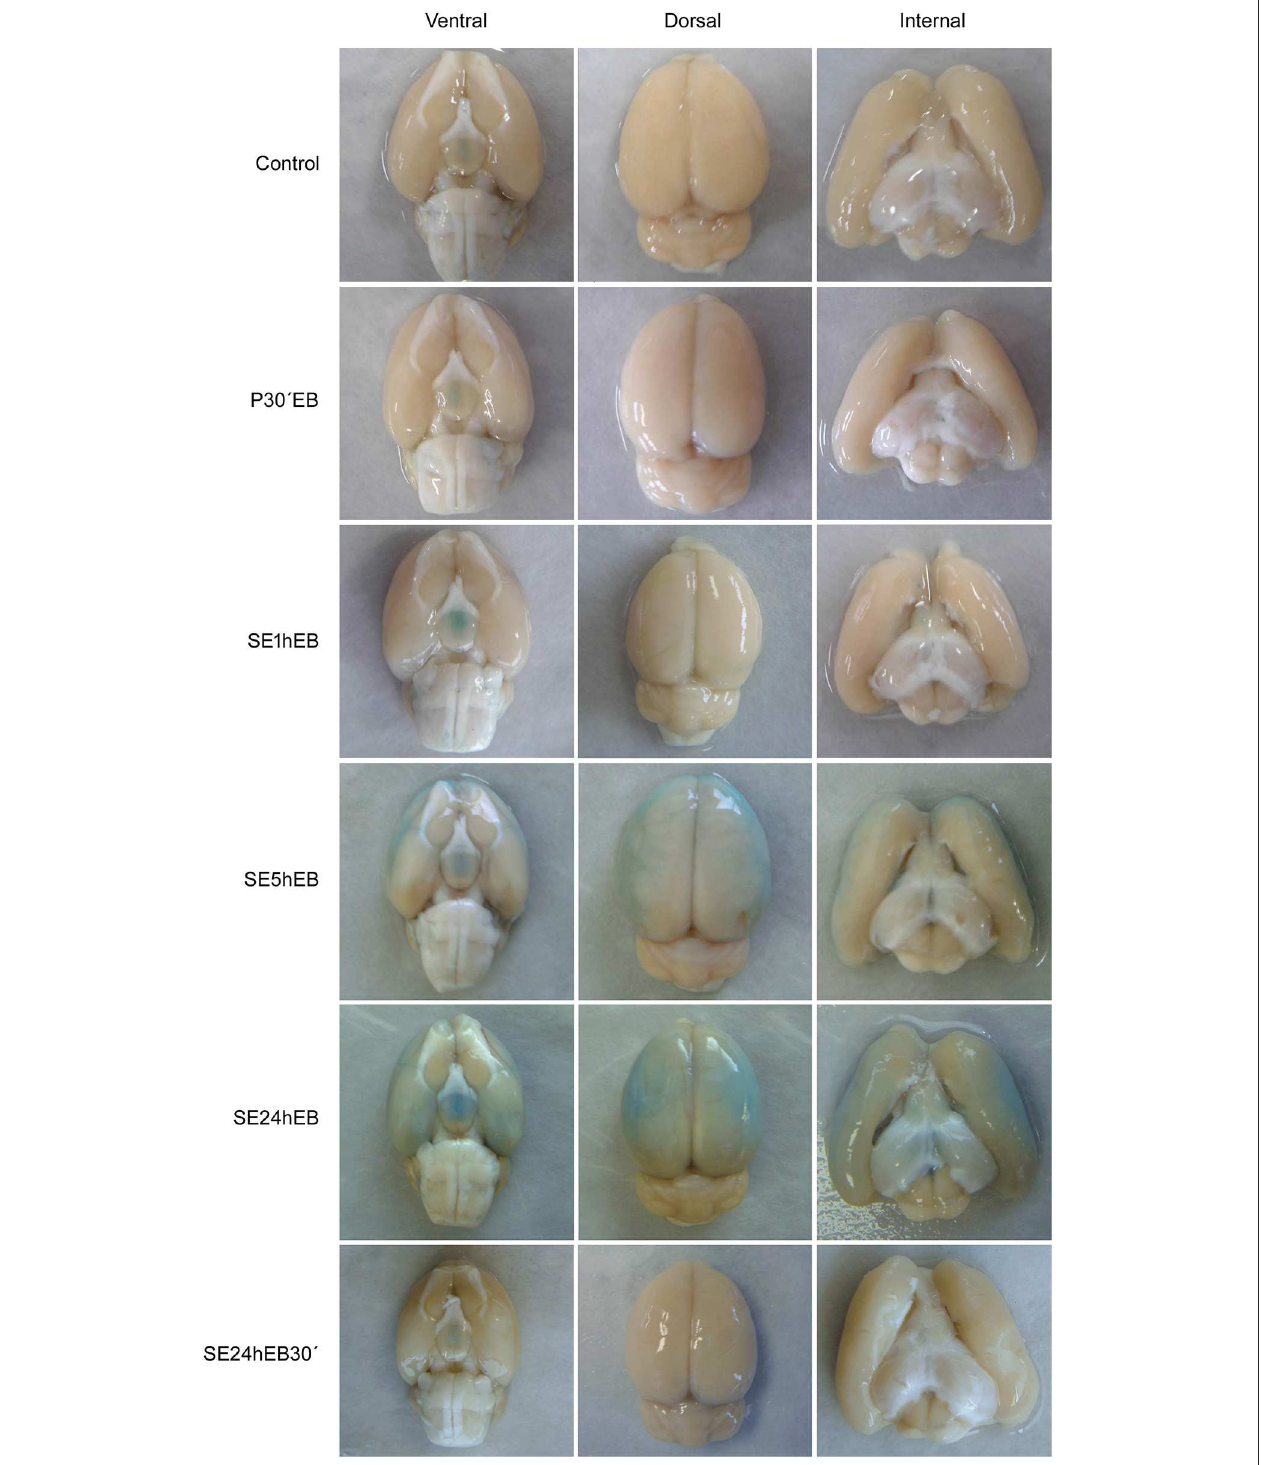
FIGURE 3 | Macroscopic analyses of rats’ brains after EB dye injection during the acute phase of the pilocarpine-induced epilepsy model. Representative images of the ventral (left column), dorsal (middle column), and internal (right column) views of the brains after EB injection. Note the EB dye in the neocortex of rats from the SE5hEB group and in the SE24hEB group, the presence of EB dye in the neocortex and entorhinal cortex. In the SE24hEB30’ group, note the absence of dye in the brain tissue.